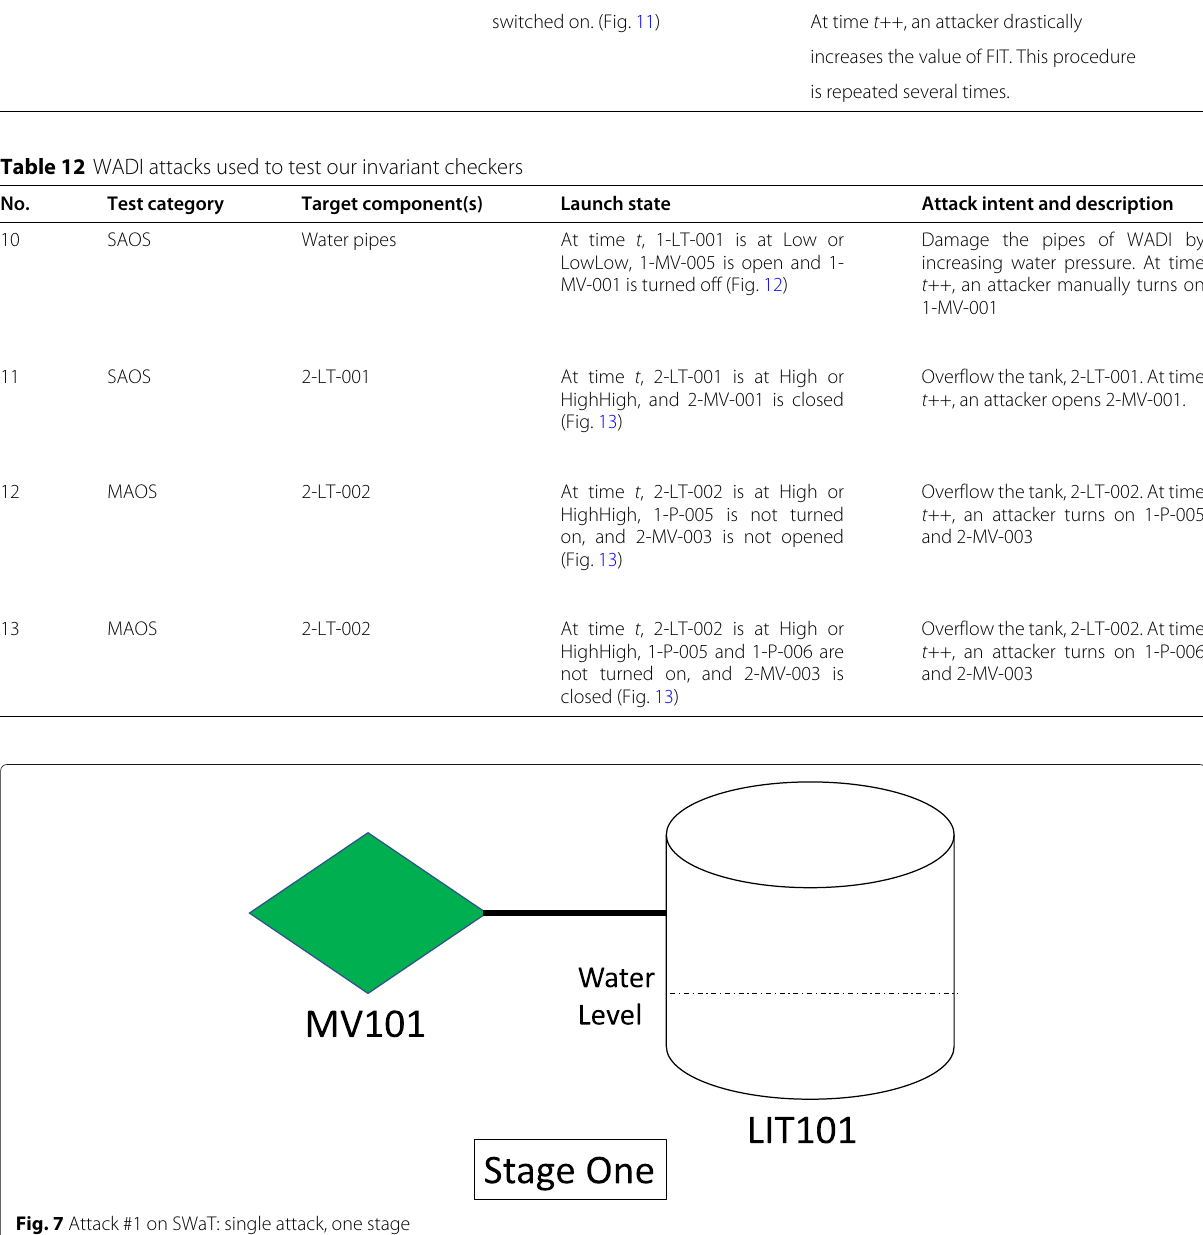
Fig. 7 Attack #1 on SWaT: single attack, one